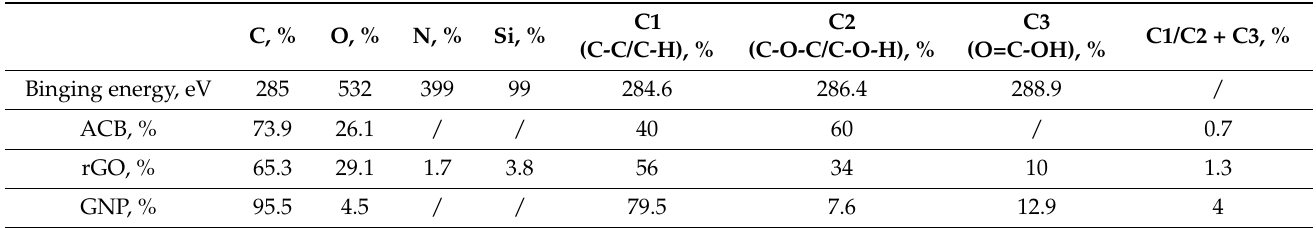
Table 1. Chemical composition (atomic %) determined using XPS.